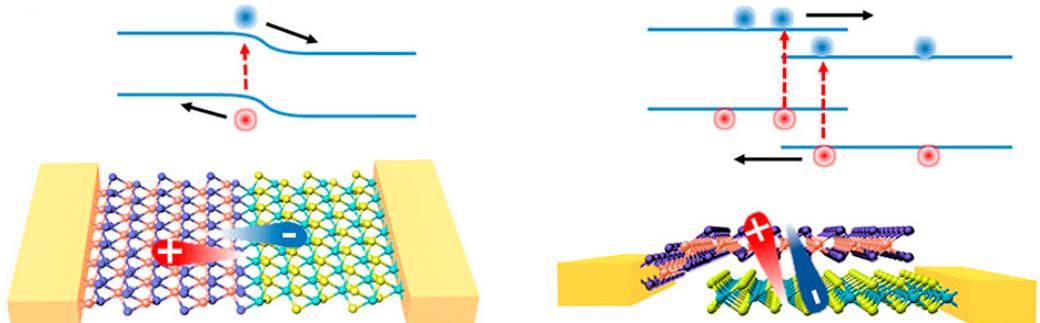
Figure 5. In-plane p–n junction ( left ) and out-of-plane p–n junction ( right ) of 2D materials, and their respective electronic band alignment. Reprinted with permission from ref. [6]. © 2017, AIP Publishing.